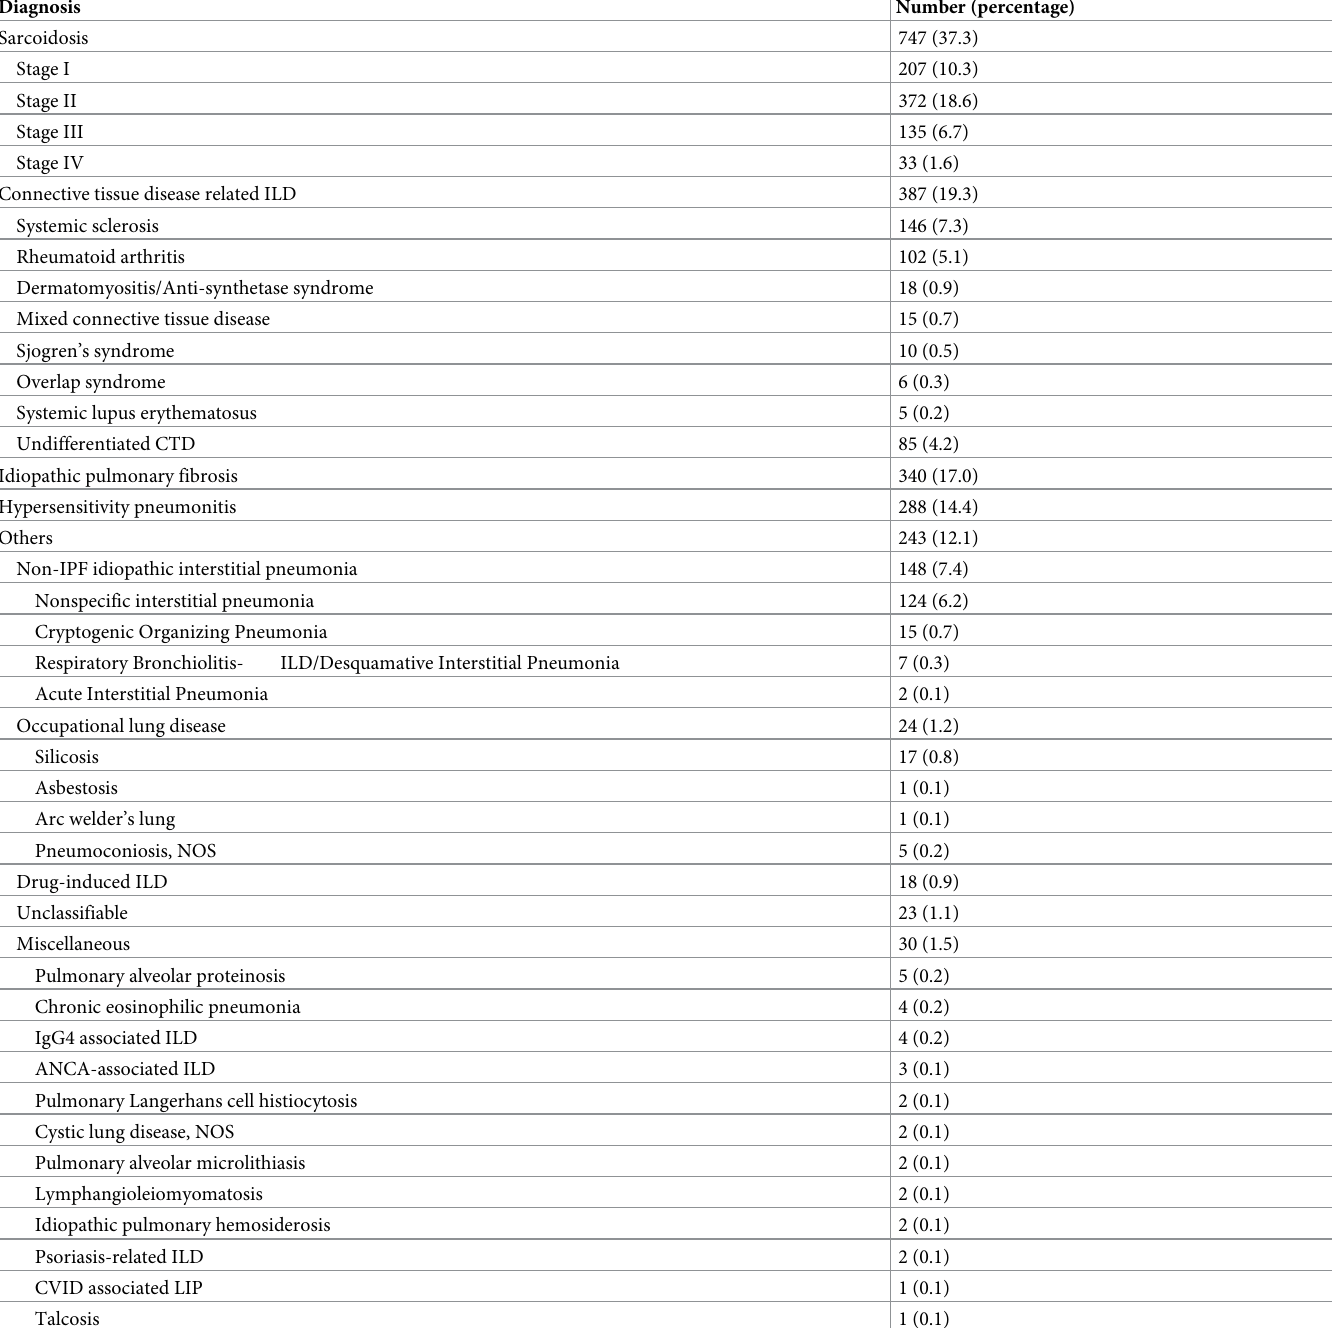
Table 3. Final diagnoses of study subjects assigned after complete evaluation in the Chest Clinic (n =